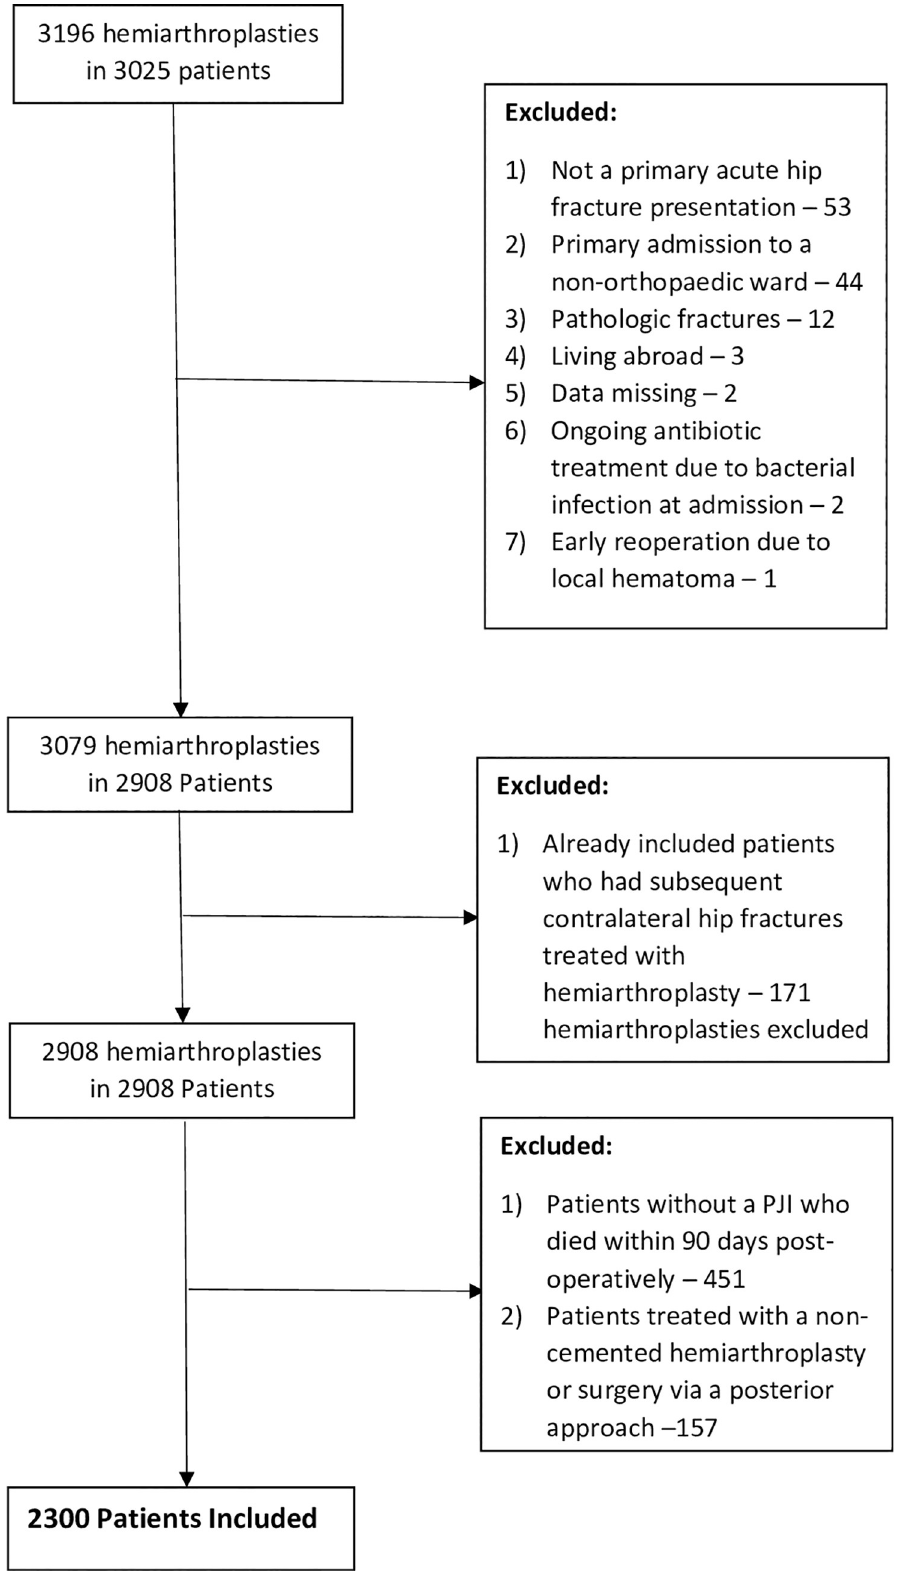
Fig 1. Reasons for exclusion of patients treated with a hemiarthroplasty after a hip fracture. https://doi.org/10.1371/journal.pone.0229947.g001 PLOS ONE | https://doi.org/10.1371/journal.pone.0229947 March 12,